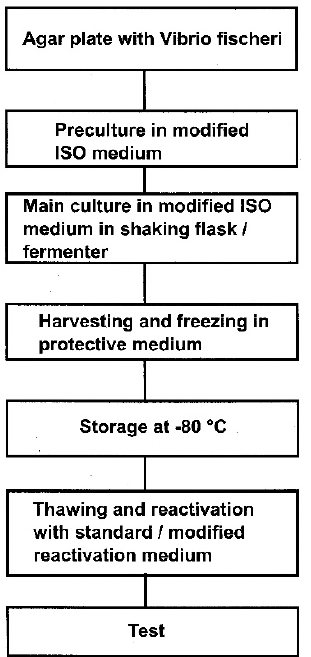
Figure 1. Schematic view of the procedure of preparing luminescent bacteria for a test. Table 1. Composition of the original and modified growth medium. Di ff erences to the original medium are indicated in